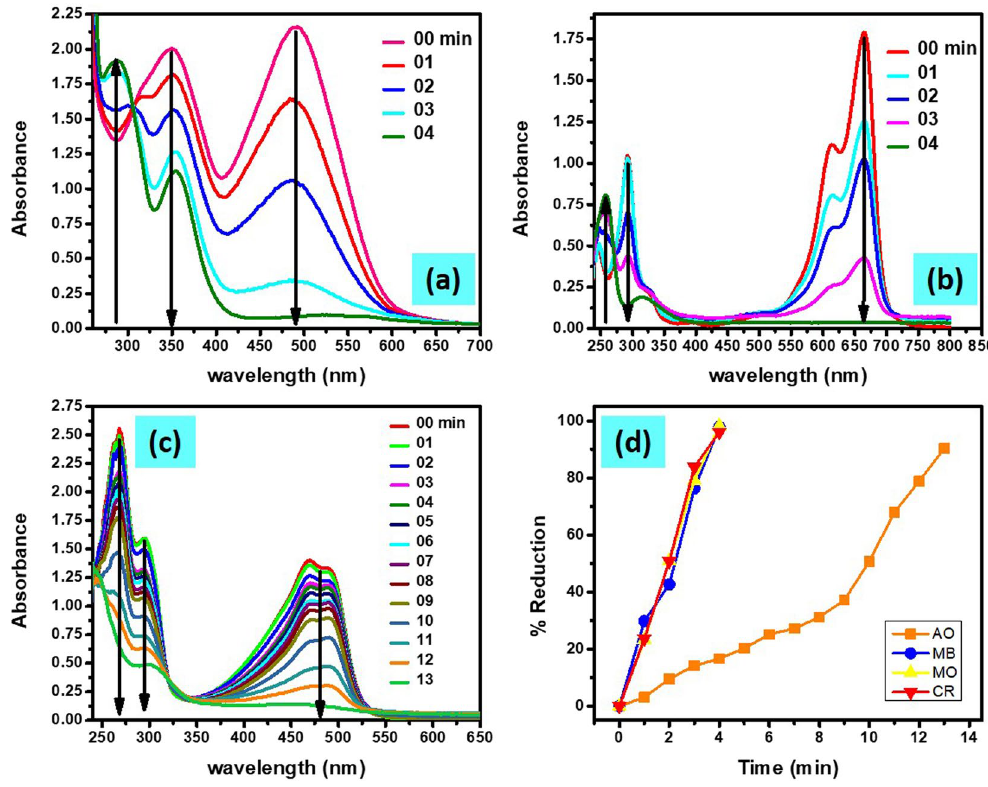
Figure 9. UV-visible spectra of CR ( a ), MB ( b ), and AO ( c ) solutions containing Cu/CS-TiO 2 -15 and percent reduction of MO, CR, MB and AO as a function of time ( d